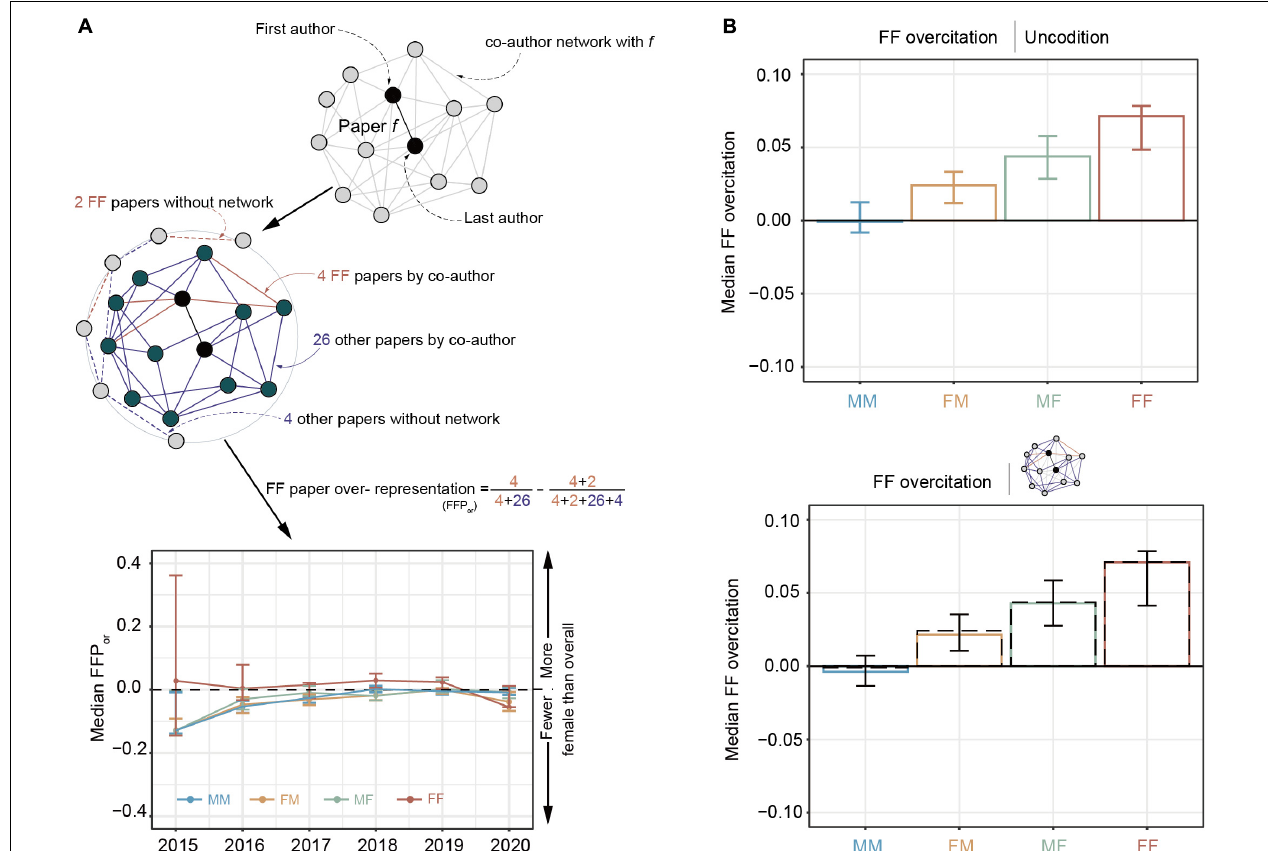
FIGURE 4 | Display of the composition measurement of the co-author network. (A) Examples of calculation of the FF paper overrepresentation (FFP or ) for the specific paper, and the median FF papers in the local network composition based on author gender from 2015 to 2020. (B) Over-citation of FF papers without network (the bar graph above and the dashed graph below) and after accounting for network (the bar graph below) influence. The bar graphs represent median FF papers of different gender groups (MM, FM, MF, and FF). The error bars represent the 95% CI of each estimation, which was calculated from 1,000 bootstrap resampling iterations There is only a slight median difference in the citation behavior (MM, –0.001 and –0.004; FM, 0.024 and 0.022; MF, 0.044 and 0.043; and FF, 0.071 and